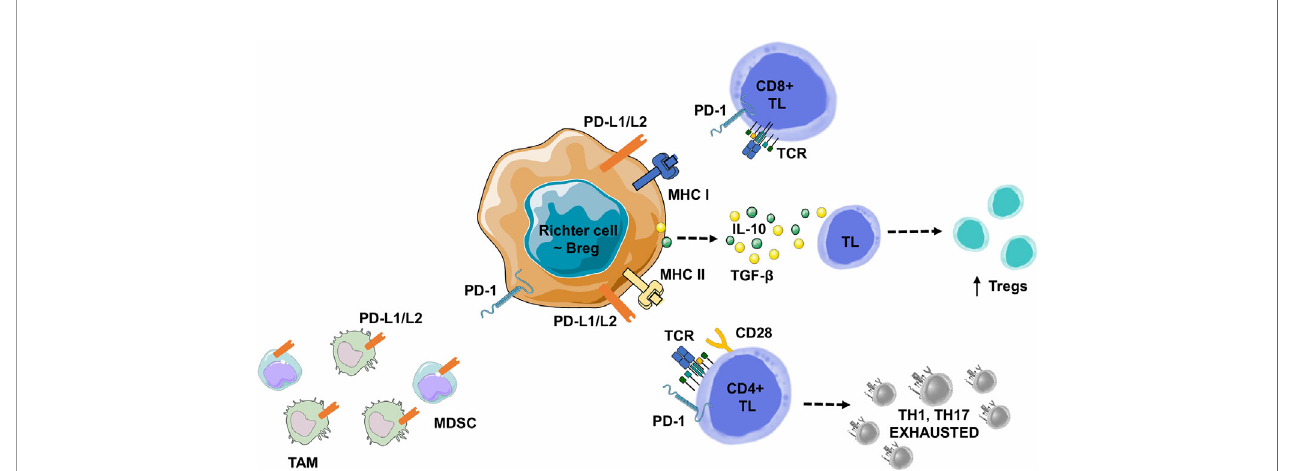
FIGURE 6 | Lymphoma B cell-mediated immune synapse in Richter syndrome. This fi gure focuses on mechanism of tumoral escape in the germinal center of lymph nodes. PD-1 delivers inhibitory signals to TLs after binding with its ligands PD-L1 or PD-L2, on the surface of malignant B lymphocytes, in the tumor microenvironment. Behdad et al. (99). hypothesize that in RS, tumoral B lymphocytes share characteristics with Bregs: i) expression of co-inhibitory ligands such as PD-L1/PD-L2, allowing TL exhaustion, ii) the ability to induce FOXP3+ Treg expansion, and iii) the ability to recruit Myeloid-Derived Suppressor Cell (MDSC) or monocytes/macrophages (TAMs). Malignant B-cells can also directly express a variety of suppressive ligands and cytokines: i) TGF- b to promote Treg development and inhibit the differentiation of CD4+ TLs into Th1 or Th17 lymphocytes, and ii) IL-10 to promote CD4+ CD25+ FOXP3+ Treg development and Fas-L production (particularly for CD5+ B lymphocytes), leading to cell death in vitro . Bregs, Regulatory B Lymphocytes; IL-10, Interleukine 10; IFN g , Interferon Gamma; MDSC, Myeloid-Derived Suppressor Cell; MHC, Major Histocompatibility Complex; PD-1, Programmed Death 1; PD-L1, Programmed Death Ligand 1; PD-L2, Programmed Death Ligand 2; RS-DLBCL, Richter Syndrome, Diffuse Large B-Cell Lymphoma subtype; TAM, Tumor Associated Macrophage; TCR, T-cell Receptor; TGF- b , Transforming Growth Factor Beta; TL, T Lymphocyte; Tregs, Regulatory T